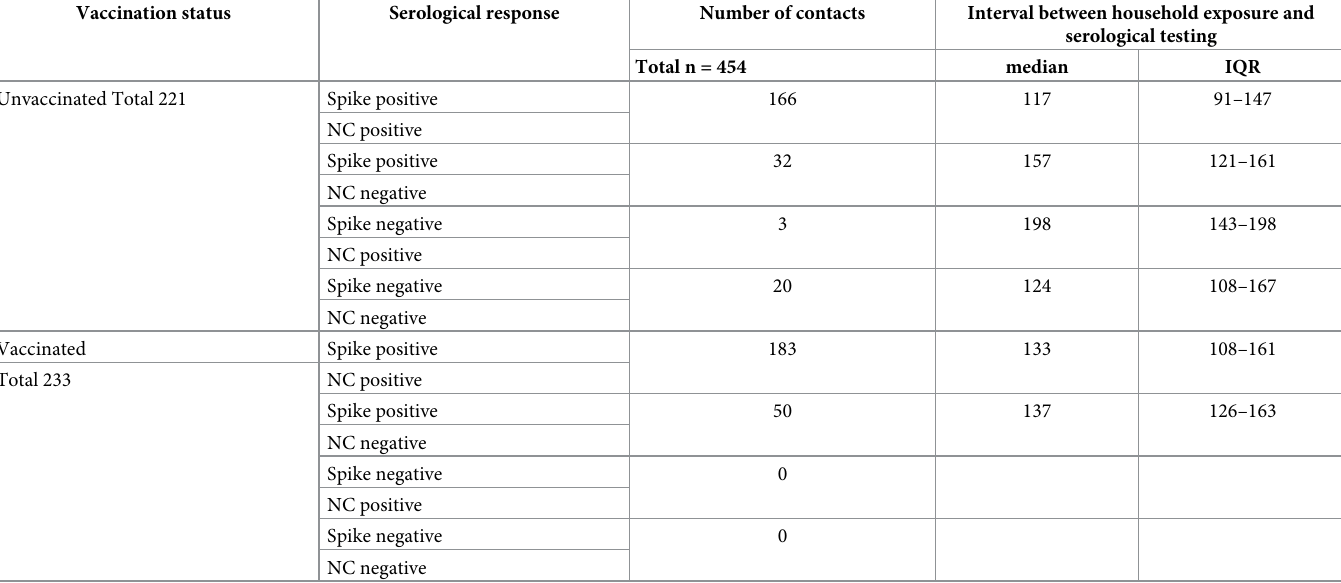
Table 4. Relationship between vaccination status, antibody positivity and the interval between household exposure (PCR positive test in index case) and serological testing of HHC. Vaccination status